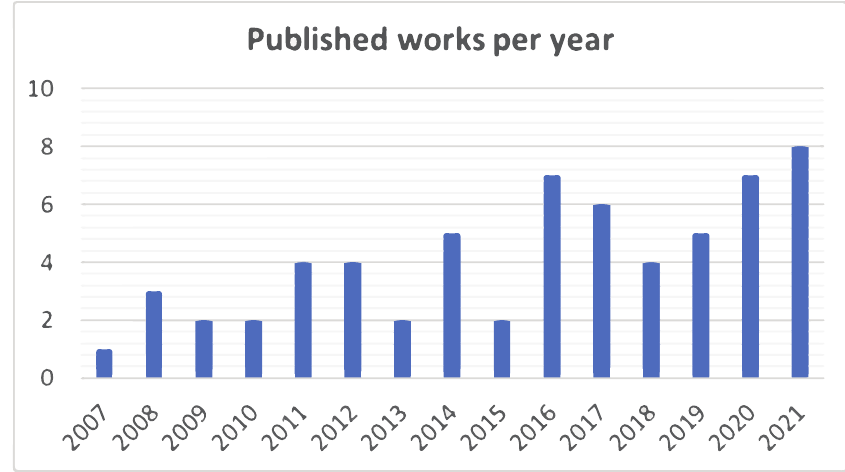
Figure 8. Published works per year.